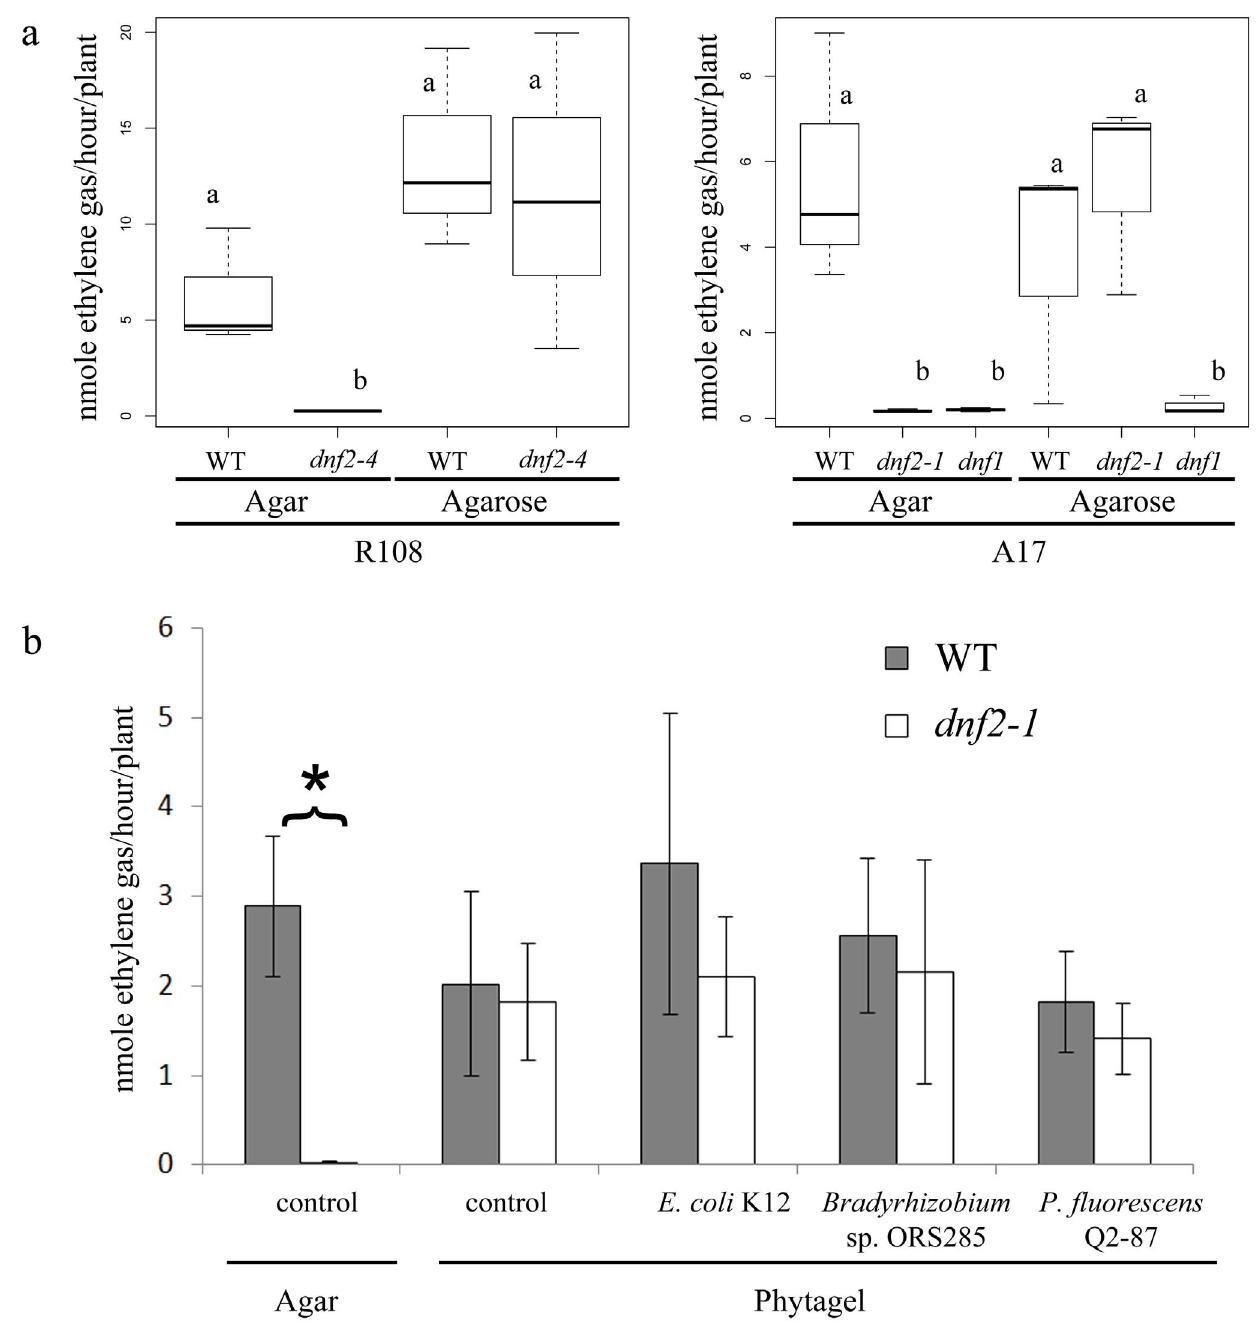
Figure 3. Plant growth conditions determine the DNF2 requirement for symbiosis. a) Acetylene reduction assays were conducted on M. truncatula WT ecotype R108 and A17 and dnf2–4 (R108 genetic background), and dnf2-1 , dnf1 mutants (A17 genetic background) inoculated with S. medicae strain WSM419. A Kruskal-Wallis one-way ANOVA test and a post-hoc Tukey’s test were performed and statistically identical values were attributed identical letters (n=3). (b) Acetylene reduction assay was conducted on M. truncatula WT ecotype A17 and dnf2-1 mutant inoculated with strain WSM419 alone (control) or in combination with E. coli K12, Bradyrhizobium sp. ORS285 or P. fluorescens Q2–87. Plants were grown under in vitro conditions on BNM supplemented with either agar or agarose and analyzed at 14 dpi (a) or with Agar and Phytagel and analyzed at 25 dpi (b). A Mann-Whitney test was performed between WT and dnf2-1 mutant for each condition. The star indicates a significant difference (p-value , 0.05) (n=4) Error bars represent standard errors.